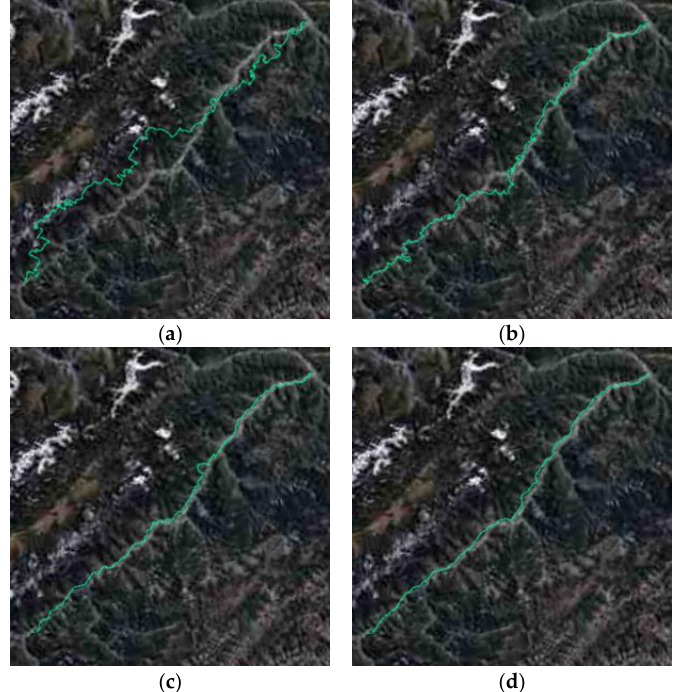
Figure 14. Global optimal solutions for different iterations t . ( a ) t = 1; ( b ) t = 25; ( c ) t = 50; ( d ) t = 100.